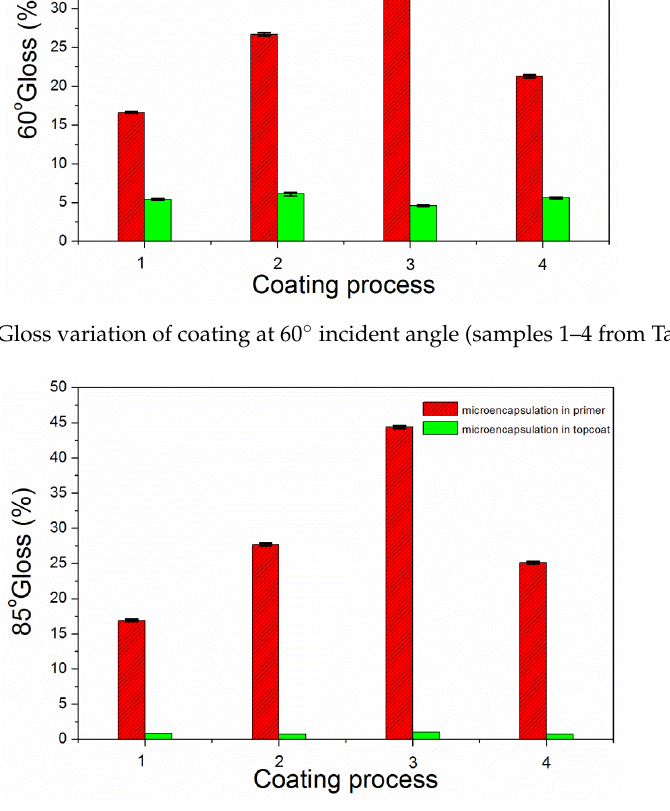
Figure 11. Gloss variation of coating at 85 ◦ incident angle (samples 1–4 from Table 1).